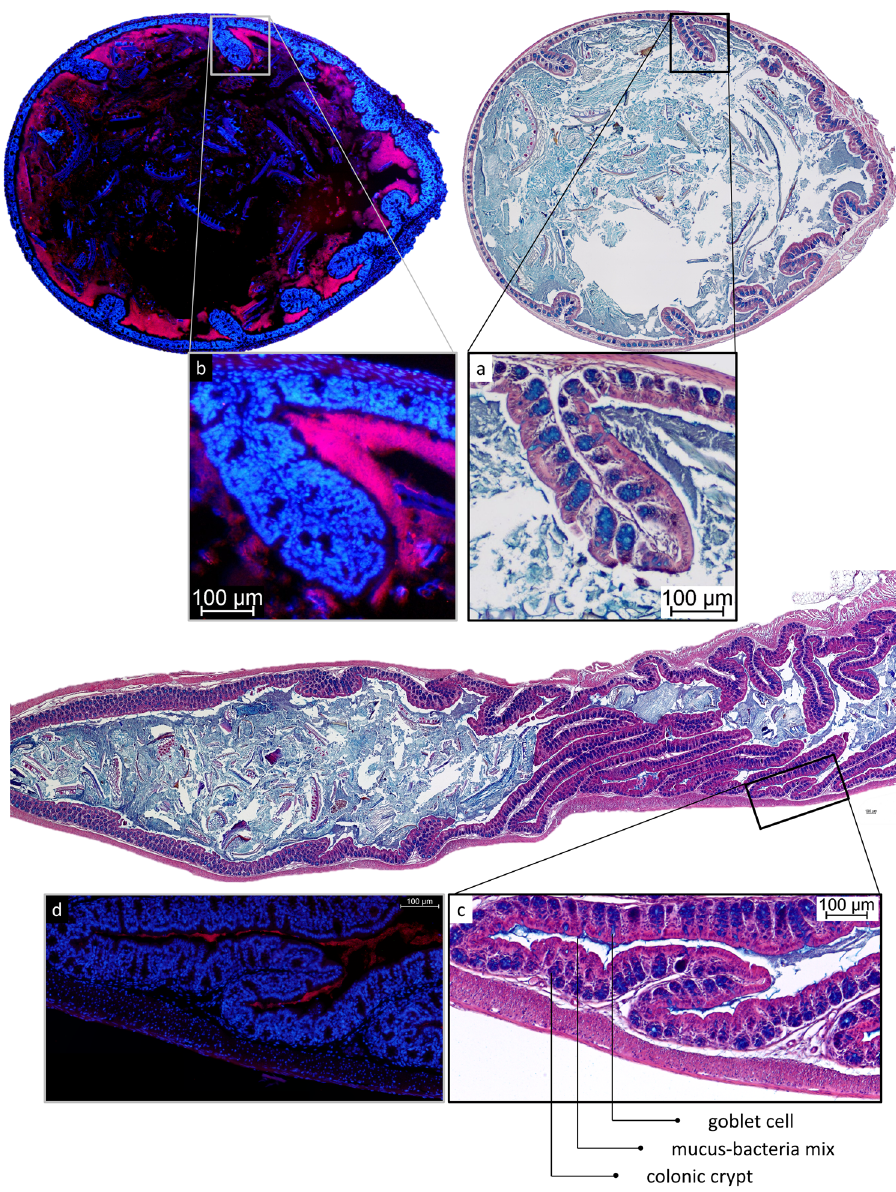
Figure 8. Localisation of microbiota in mouse proximal colon. ( a ) AB/H/E staining of transversal section of mouse proximal colon. ( b ) FISH staining of consecutive transversal section of mouse proximal colon. Bacteria are observed in direct contact with the epithelium ( a ), without a mucus layer to separate them from the tissue ( a , b ). Significantly less bacteria are observed in the middle of the contents than near to the mucosa. A high concentration of bacteria is detected particularly under the tissue folds specific to the proximal colon. ( c ) AB/H/E staining of longitudinal section of mouse proximal colon. ( d ) FISH staining of consecutive longitudinal section of mouse proximal colon. In collapsed proximal colon, bacteria mixed with mucus remain present in the lumen of folded